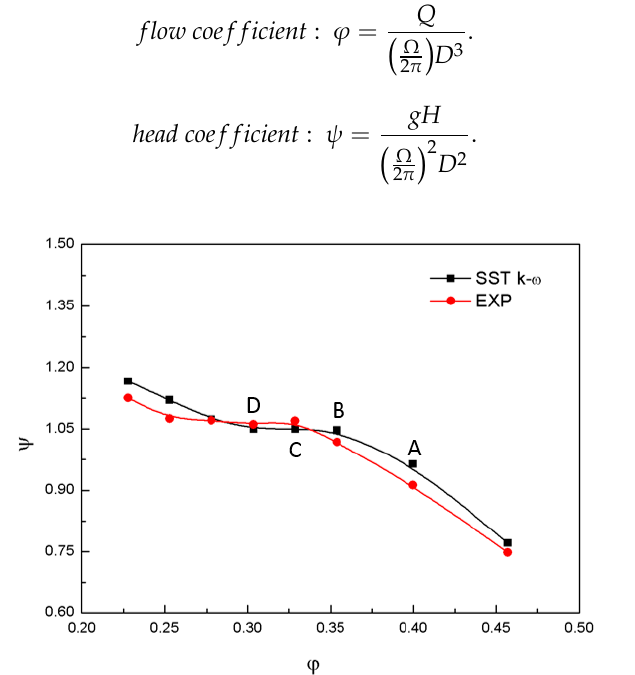
Figure 5. Comparison of simulation results and experimental data.